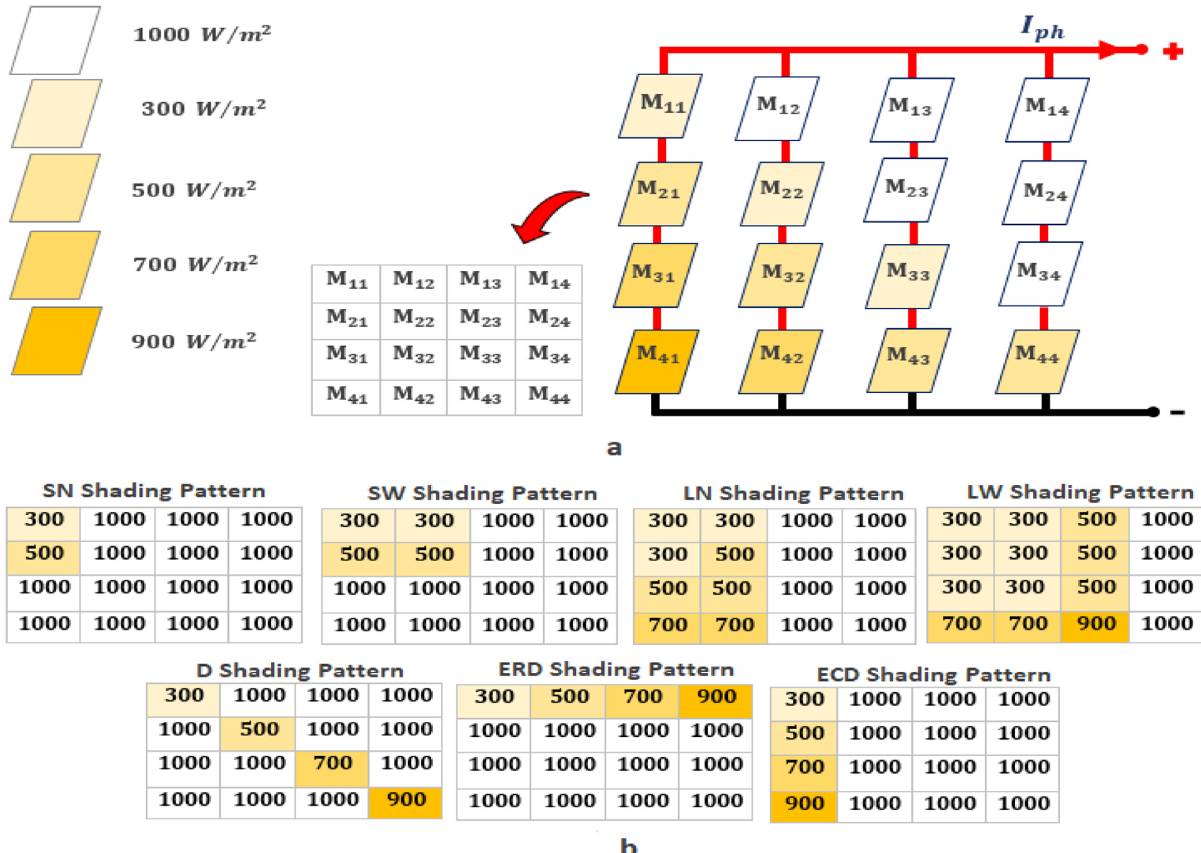
Fig. 7. Partial shading patterns (a) schematic to show position of PV modules and the solar insolation level, (b) partial shading